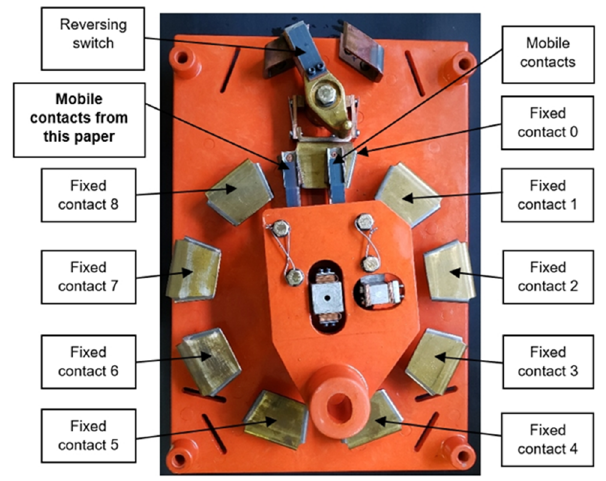
Figure 3. Position of mobile and fixed contacts on the tap changer.